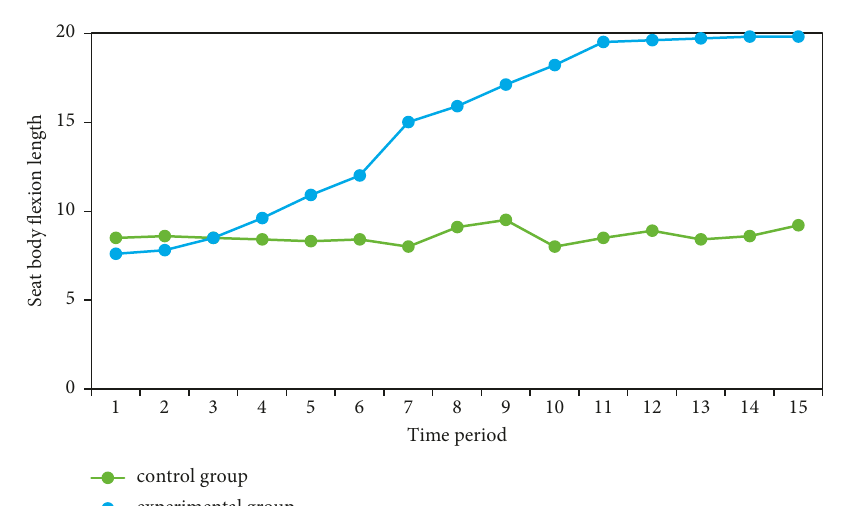
Figure 7: Flexibility index measurements.